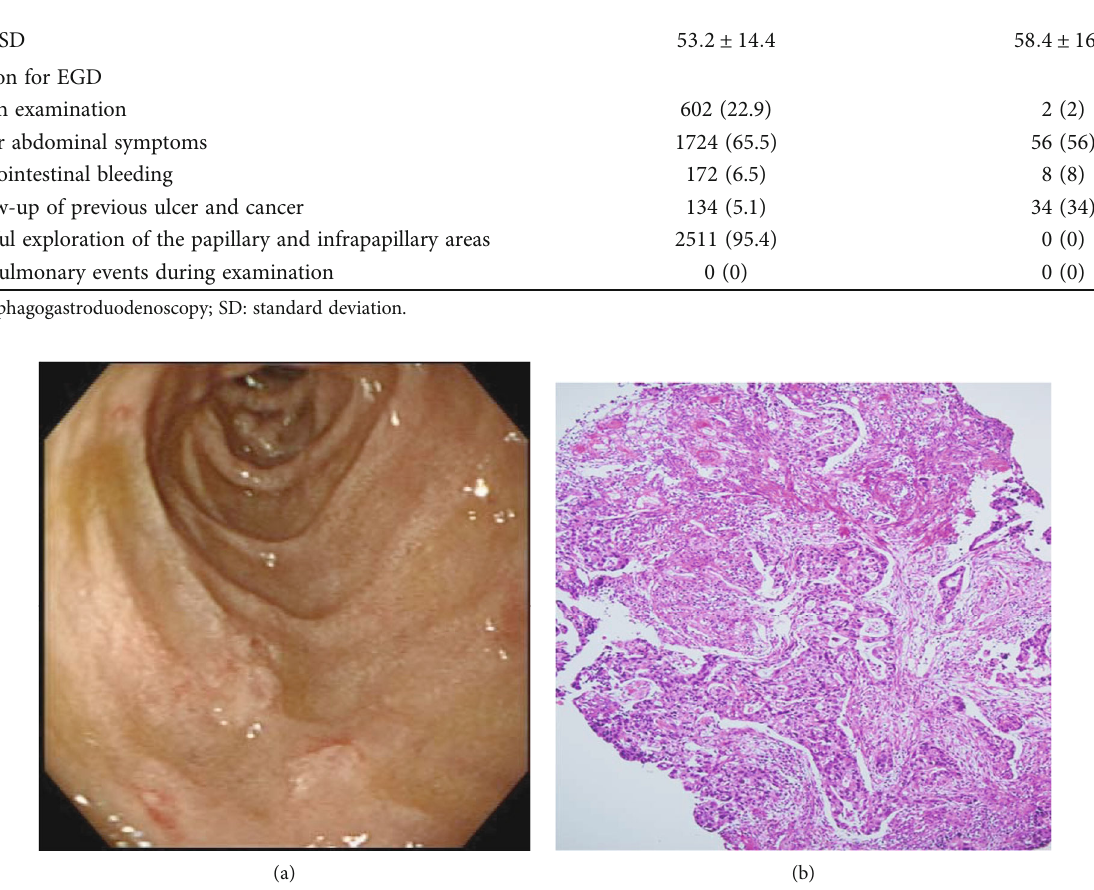
Figure 1: (a) Small polypoid lesions with shallow ulcers over the infrapapillary area (arrow). (b) Duodenal involvement of adenocarcinoma, featuring neoplastic epithelial cells arranged in irregular glands in fi ltrating the stroma (H&E,